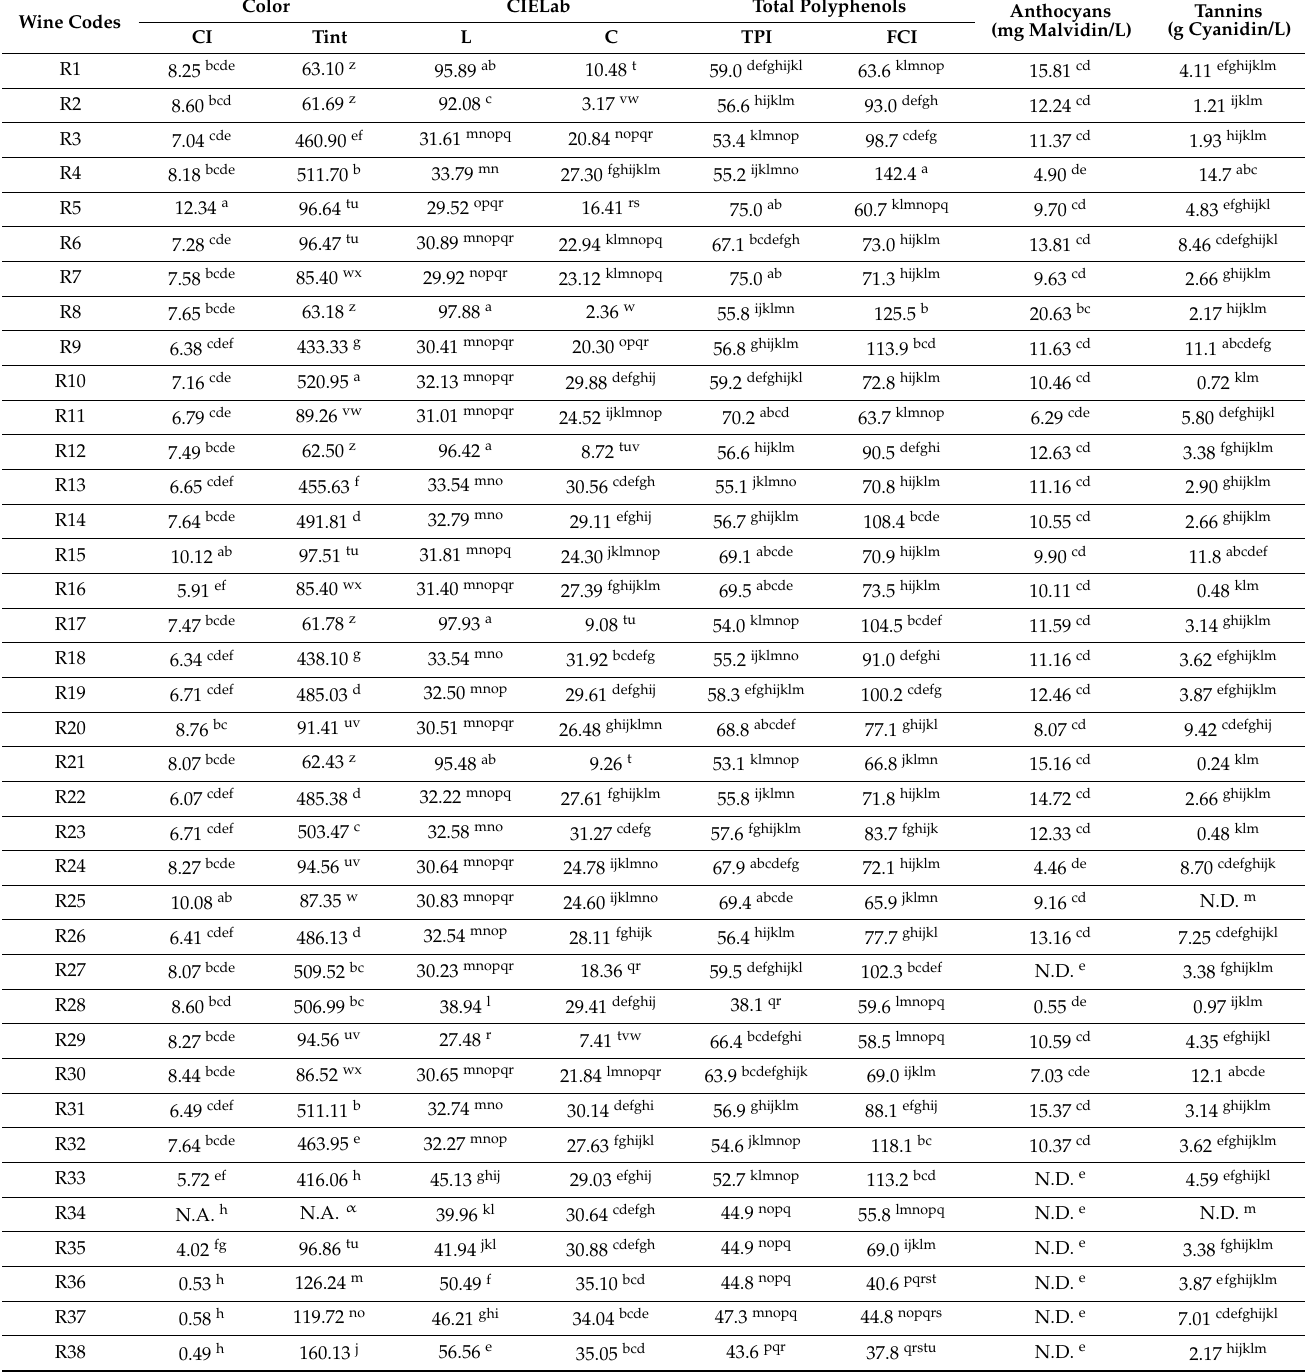
Table 2. Color and phenolic properties of red wines